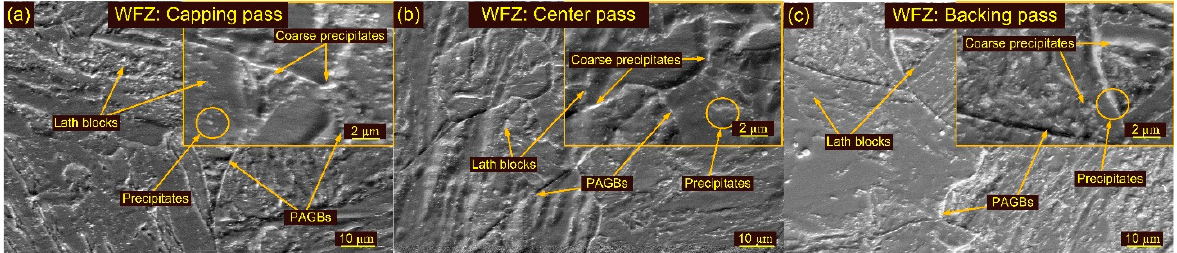
Figure 16. SEM images of weldments after HT2 treatment: WFZ ( a ) capping pass, ( b ) center pass, ( c ) backing pass.